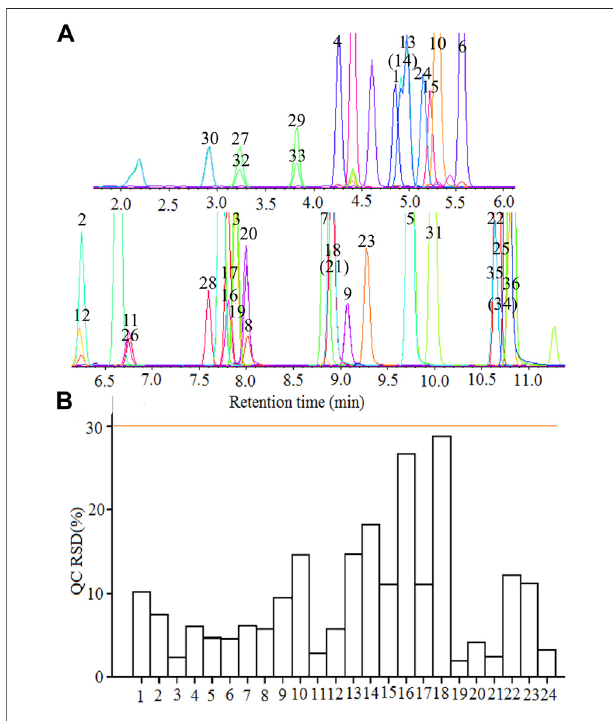
FIGURE 1 | UPLC-MS/MS determination of fl avonoid compounds. (A) The extracted ion chromatograms (XIC) of 36 fl avonoid standards; (B) The relative standard deviation (RSD) of 24 representative quality control (QC). 1 Rutin, 2 Naringin, 3 Glycetein, 4 Daidzin, 5 Isoliquiritigenin, 6 Genistin,